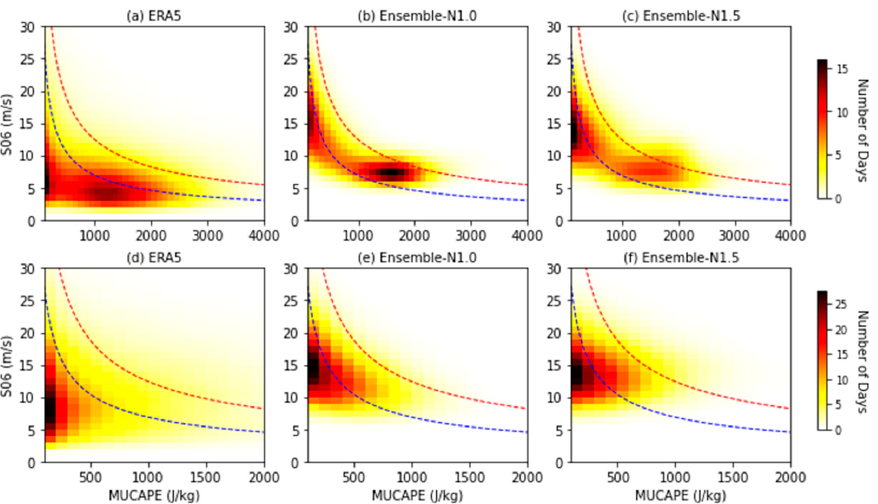
Figure 8. Climatology of environments over all land grid points of ( a – c ) d01 and ( d – f ) d02 within the space spanned by MUCAPE and S06 for ( a , d ) ERA5, ( b , e ) N1.0 and ( c , f ) N1.5 during DJF. The frequencies have been scaled as equivalent to number of days in a season. The blue (red) dash line represents the TSTORM threshold of 25,000 (68,000) for severe thunderstorm (significant severe thunderstorm) development.